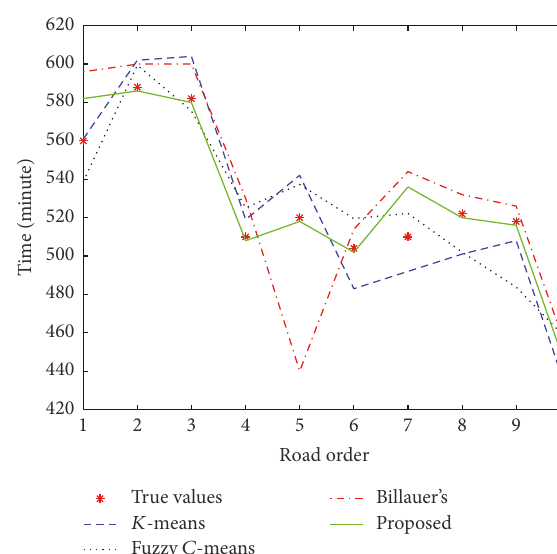
Figure 7: The detection results on Road 8.